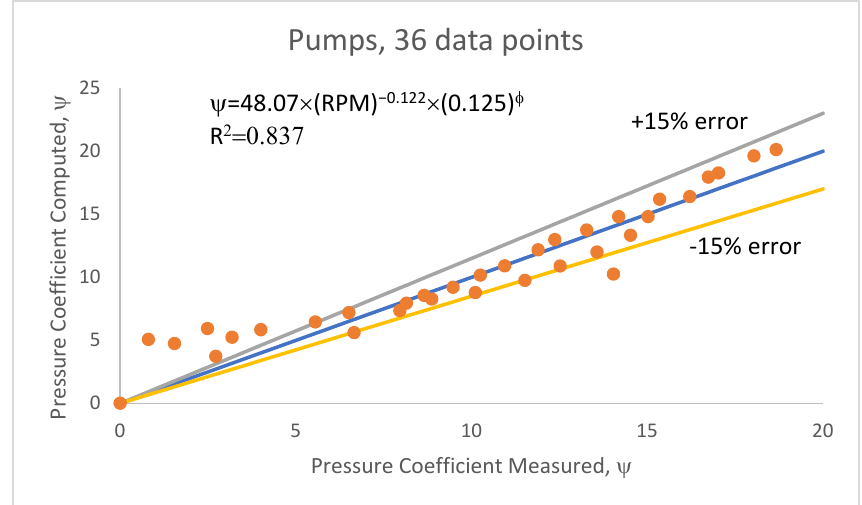
Figure 2. Computed vs. measured pressure coefficient for one ‐ side vane impeller pumps.